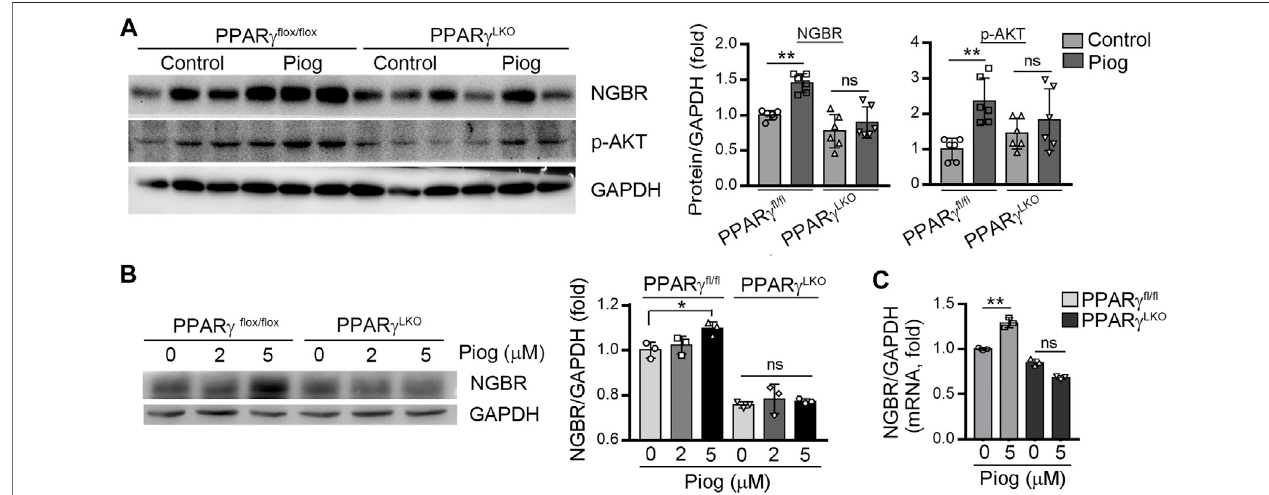
FIGURE 4 | PPAR γ plays a signi fi cant role in pioglitazone-activated NGBR expression in vivo . (A) Pioglitazone (30 mg/kg) or corn oil was i.g. administrated with PPAR γ fl ox/ fl ox and PPAR γ LKO mice for 5 days. After treatment, liver total proteins were collected. Expression of NGBR and p -AKT in mouse liver was determined by Westernblot.Valueswereexpressedasmeans ± SD.* p < 0.05;ns,notsigni fi cant( n (cid:1) 6); (B,C) mouseprimaryhepatocytestreatedwithvehicleorpioglitazone(10 μ M) for 24 h. The expression of NGBR protein and mRNA was determined by Western blot (B) or qPCR (C) , respectively. Values were expressed as means ± SD. * p < 0.05; ** p < 0.01; ns, not signi fi cant ( n (cid:1)